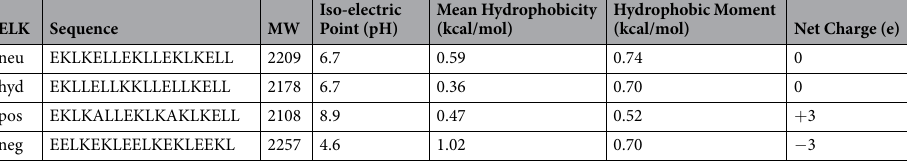
Table 1. Physicochemical properties of ELKs. Wimley-White hydrophobicity indices 68 were used for calculation of Mean Hydrophobicity and Hydrophobic